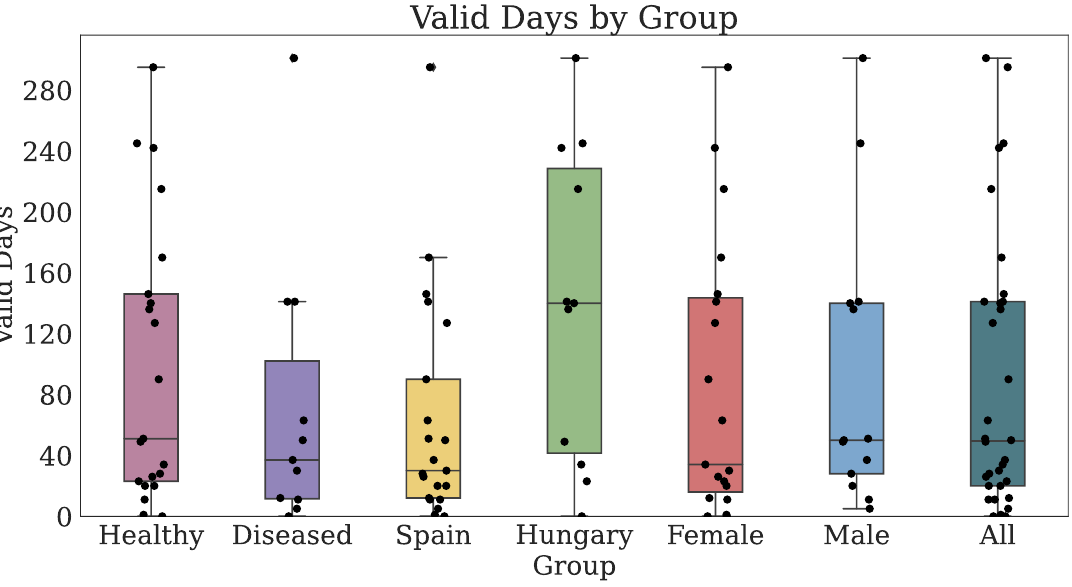
Figure 7. Days of Fitbit (TechRO) valid days data for seniors with at least one PRO